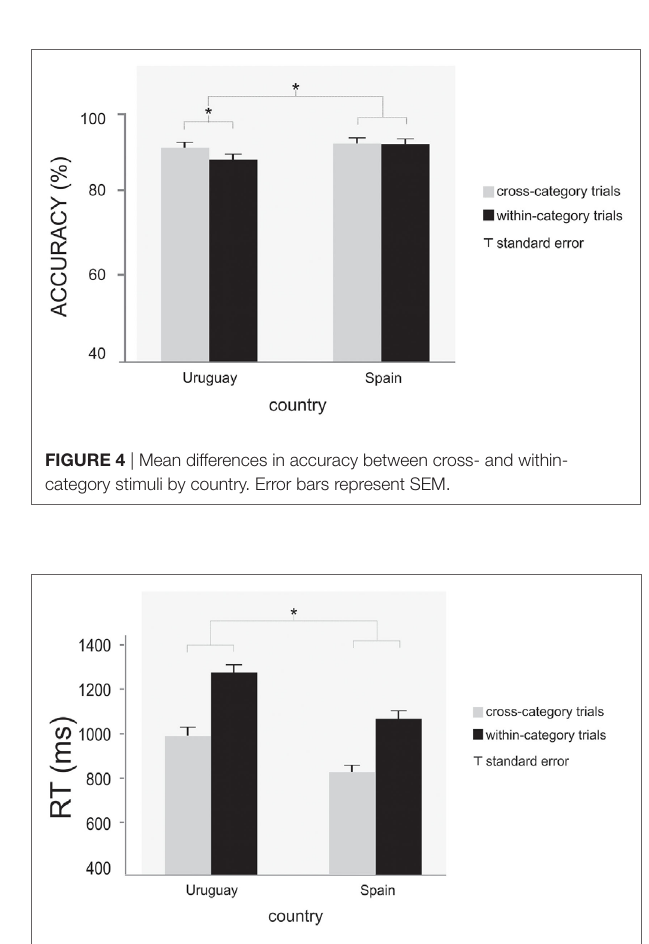
FigUre 5 | Mean response times (ms) between cross- and within-category stimuli by country. Error bars represent SEM.